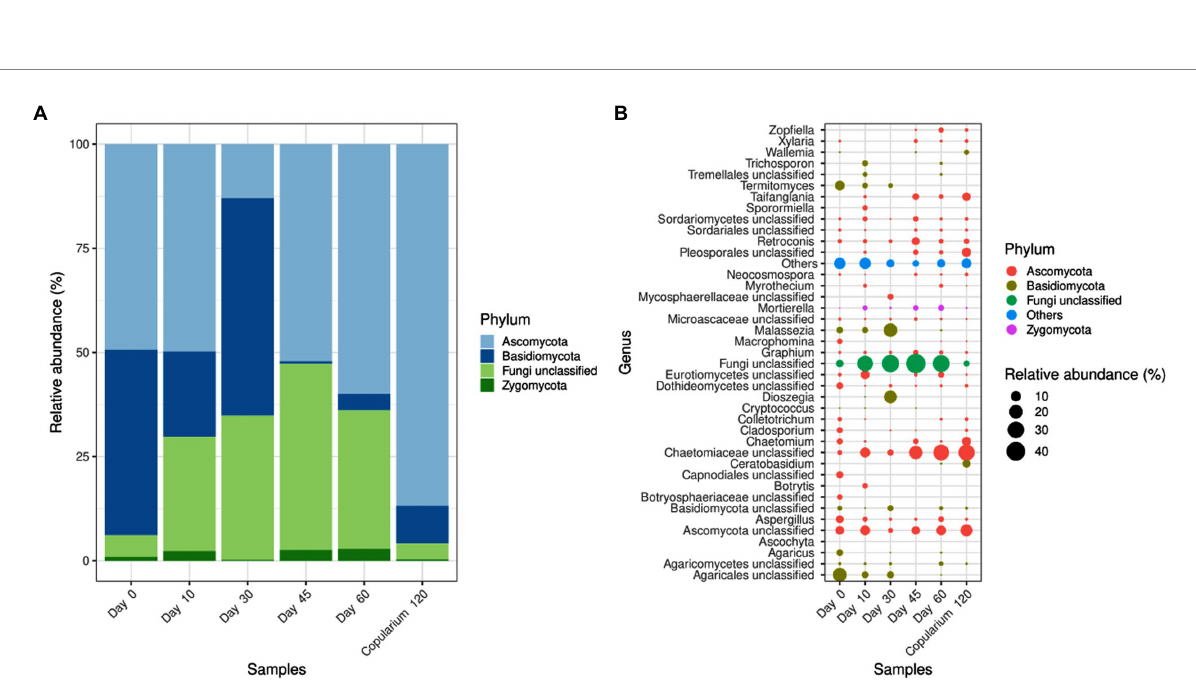
FIGURE 5 Phylum-level (A) and genus-level (B) distribution of fungal taxa in the gut of M. subhyalinus reproductives over the colony foundation period, in comparison with the copularium at day 120. For the genus-level, only the 40 most abundant taxa of the data set are displayed. The dot sizes are proportional to the relative abundance of the corresponding taxa in each library and the absence of dot indicates the non-detection of the corresponding taxon in a given library. « Others » refers to the sum of relative abundances of less abundant